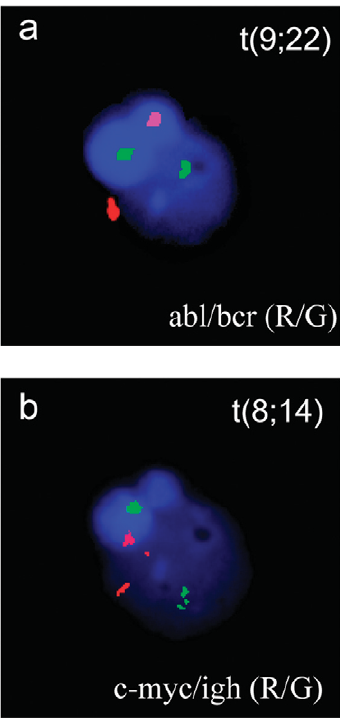
Fig. 3. A biphasic nucleus of a polymorphonuclear cell (PMN) af- ter sequential FISH staining with probes abl/bcr, red/green (a), and c-myc/igh, red/green (b) representing chromosomes HSA 9, 22, 8 and 14, respectively. Signals are equitably distributed in the areas of condensed and noncondensed chromatin. In leukaemia the nuclei of PMN are known to transcribe and may also enter replication